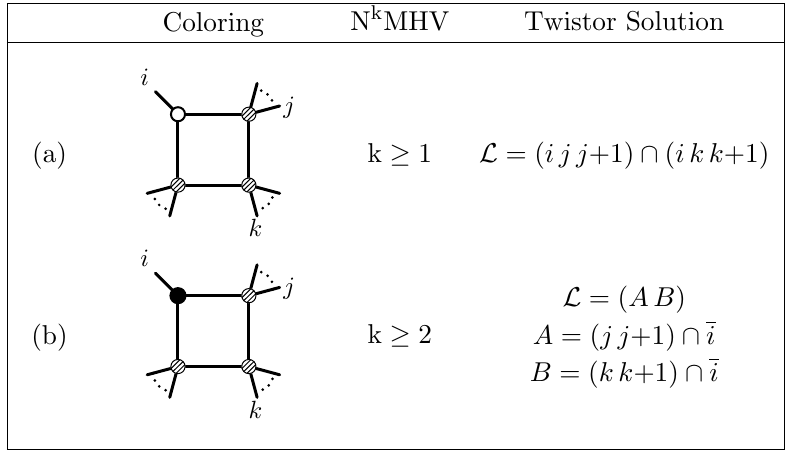
Table 7 . Two colorings of the three-mass box. Row (a) shows the NMHV coloring and momentum twistor solution to the on-shell conditions, and row (b) shows the same for the N 2 MHV solution. using either of the two three-mass box solutions shown in table 7, after an appropriate exchange of the external labels in order to match to eq. (4.10). This means there are two branches of colorings: one were the trivalent node at i is white, and one where it is black. (2) The two corresponding solutions L